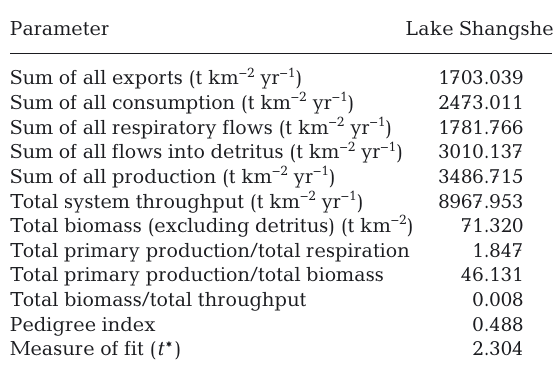
Table 6. Ecosystem properties of the Lake Shangshe eco-